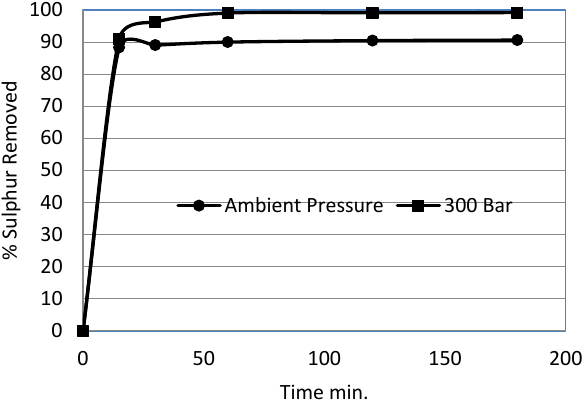
Figure 13. Effect of time on pyritic sulphur removal.